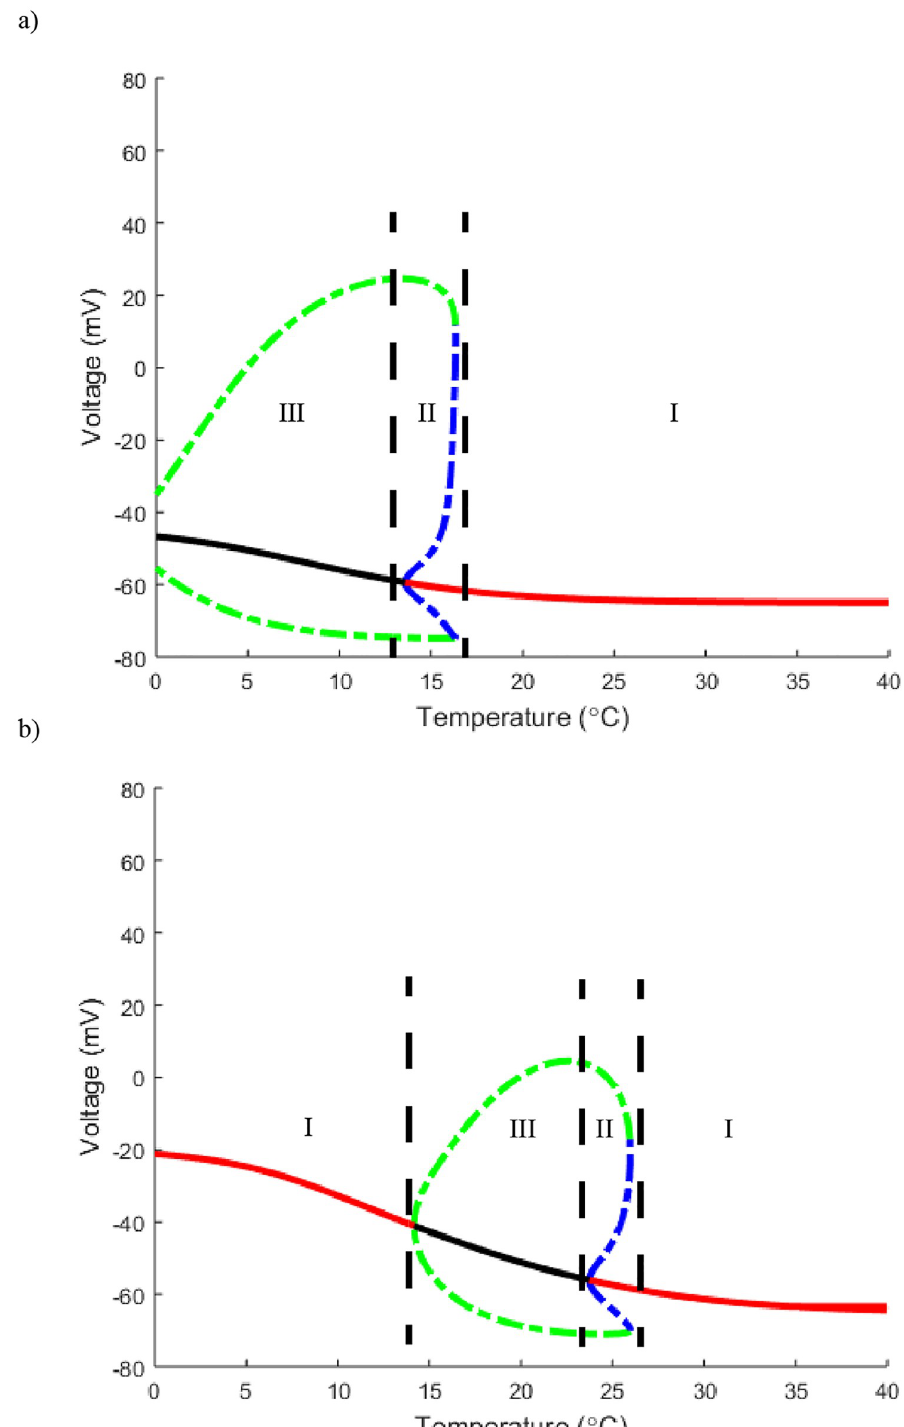
Fig 8. Horizontal one parameter bifurcation slices of Fig 6. a) A slice with g m 8 set to 3. b) A horizontal slice with g m 8 set to 50. In both a) and b) g K = 36. Curve color and labeled regions are identical in meaning to those in Fig 2.